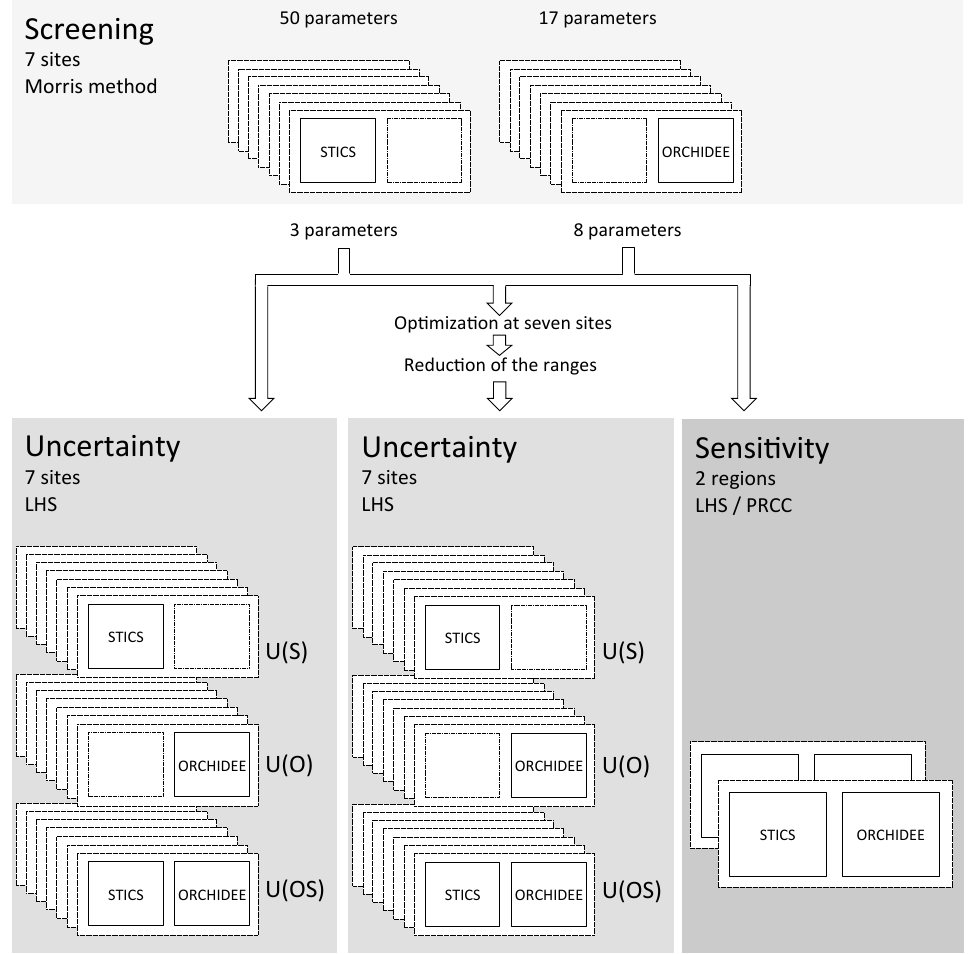
Figure 1. Flowchart of the analysis carried out in this study. The first step is the separate screening for seven sites of the STICS and ORCHIDEE parameters. The selection of parameters obtained from the screening are then used for two uncertainty analysis, one with the same parameter ranges of variation as for the screening, the other with parameter ranges of variation constrained by the optimization of the model at seven sites. Each uncertainty analysis is decomposed in three parts, one including only ORCHIDEE parameters, one including only STICS parameters and one including parameters from both ORCHIDEE and STICS. Finally a sensitivity analysis is carried out for two small regions in Australia in Brazil for all parameters together. Table 1. Description of climate and management for the sites used in this study in Australia (Ayr, Ingham, Grafton), Brazil (Piracicaba) and La Réunion (Colimaçons,